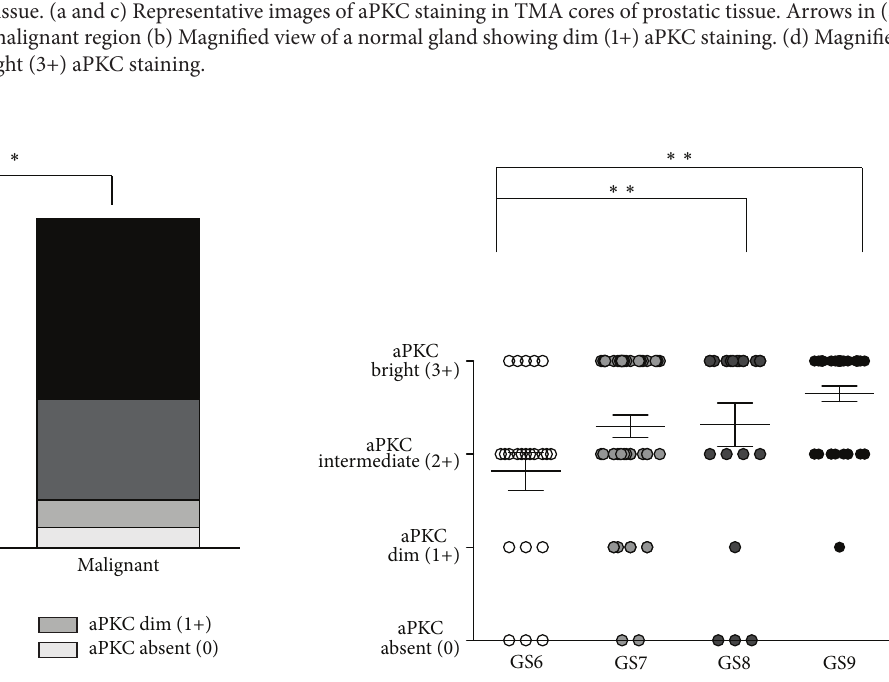
Figure 3: Correlation of aPKC staining intensity with Gleason scores. Distribution of aPKC staining intensity in prostate cancers of different Gleason scores (GS). ∗∗ 𝑃 < 0.01 , Chi-square test. Overall, aPKC scores correlated with GS, Chi-square test, 𝑃 < 0.05